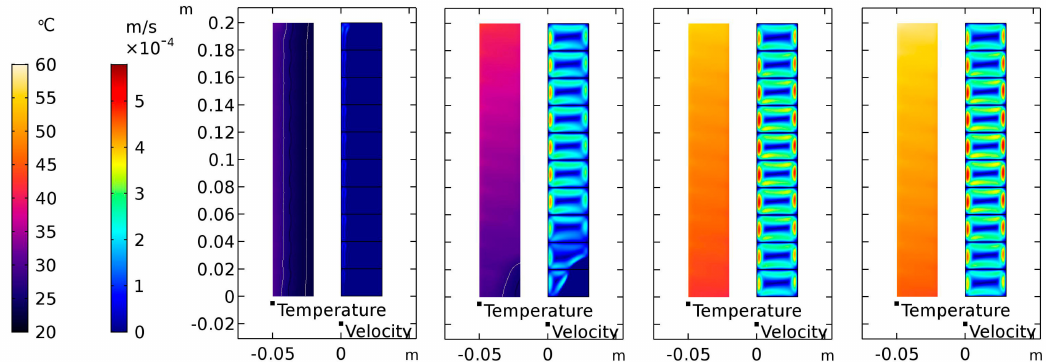
Figure 11. Results of the step 2 simulation for the segmented block (5 segments of 3 × 4 cm 2 ) after 4, 8, 12 and 16 h (from left to right); black line in temperature contour plot is the 25 ◦ C isotherm; white lines are the 23 ◦ C respectively 27 ◦ C isotherms.